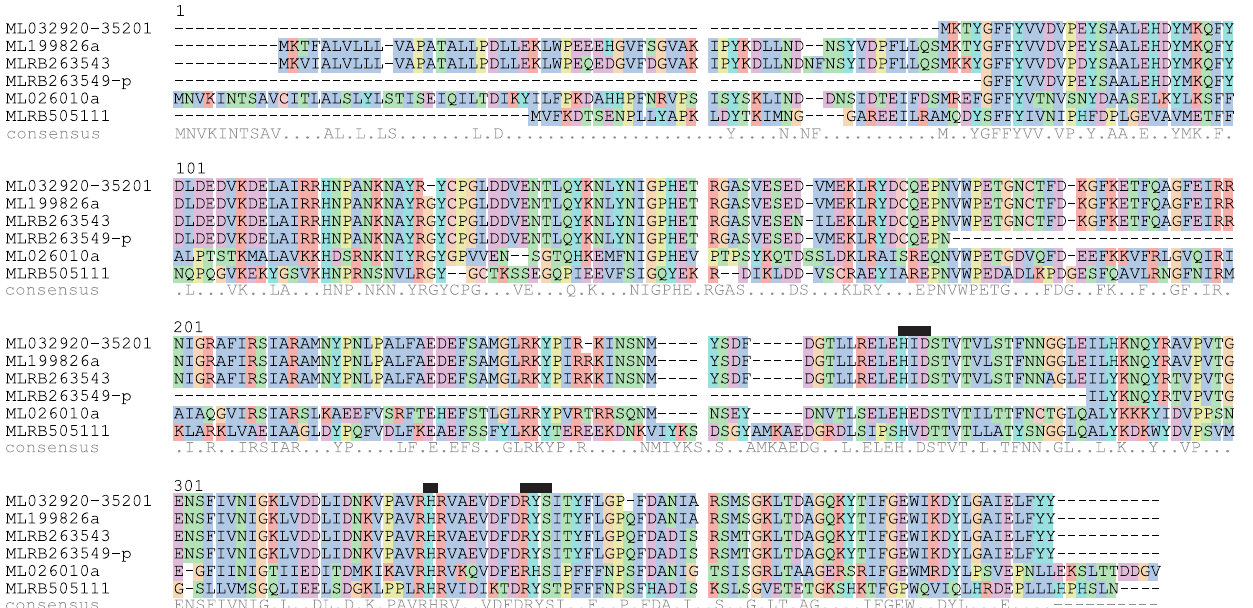
Fig 3. Multiple sequence alignment of Mnemiopsis proteins. ML032920-35201 is the putative full-length protein that connects ML032920a and ML35201a. MLRB263549-p indicates it is a partial sequence, as exons are missing in the scaffolds. The consensus sequence is indicated below, where identical residues are shown by ‘ * ’ and similar residues are shown by ‘ . ’ . Black boxes indicate the highly conserved residues putatively involved in iron and 2-oxoglutarate binding.